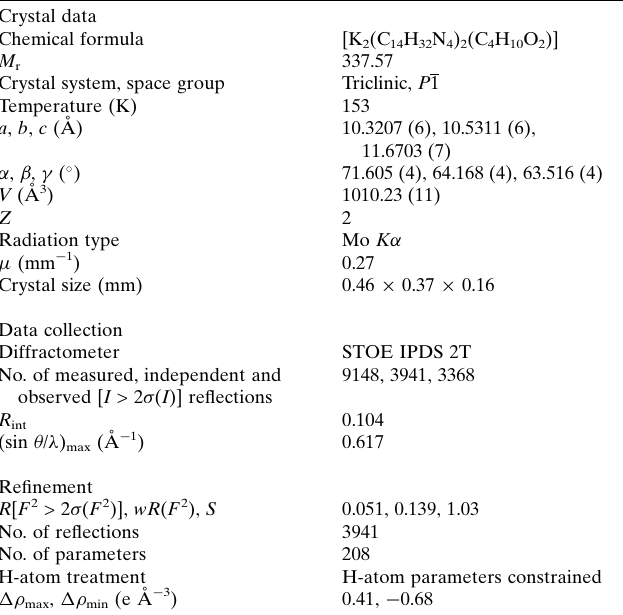
Table 1 Experimental details. Crystal data Chemical